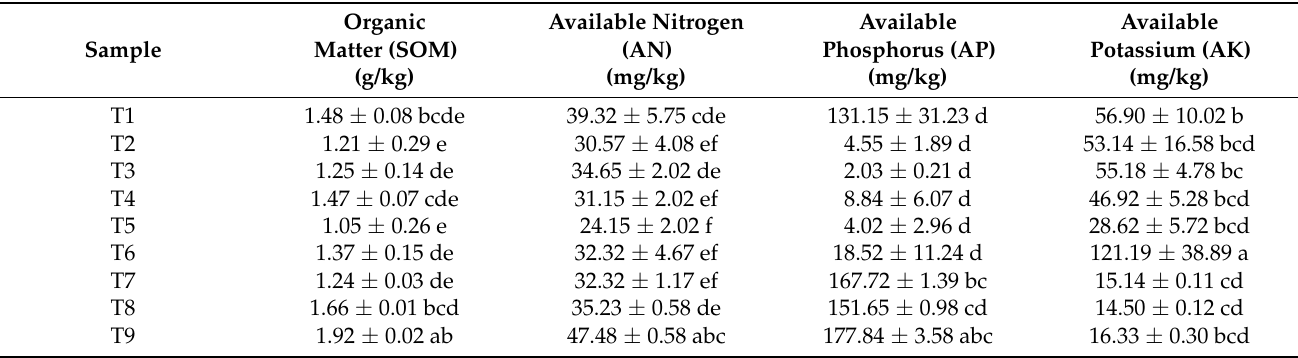
Table 1. Physical and chemical properties of soil samples from different aged apple